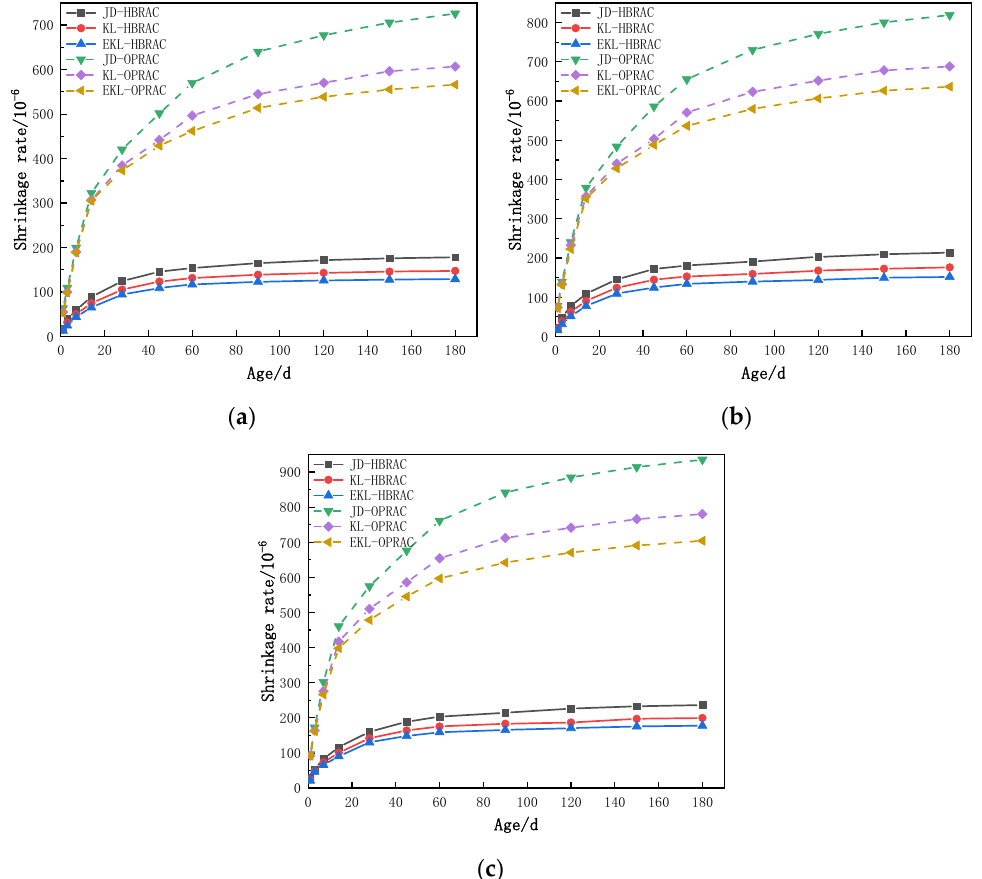
Figure 9. Comparison of drying shrinkage performance of HBRAC and OPRAC at different ages: ( a ) cementitious material content 300 kg/m³, ( b ) cementitious material content 400 kg/m³, ( c ) and cementitious material content 500 kg/m³.